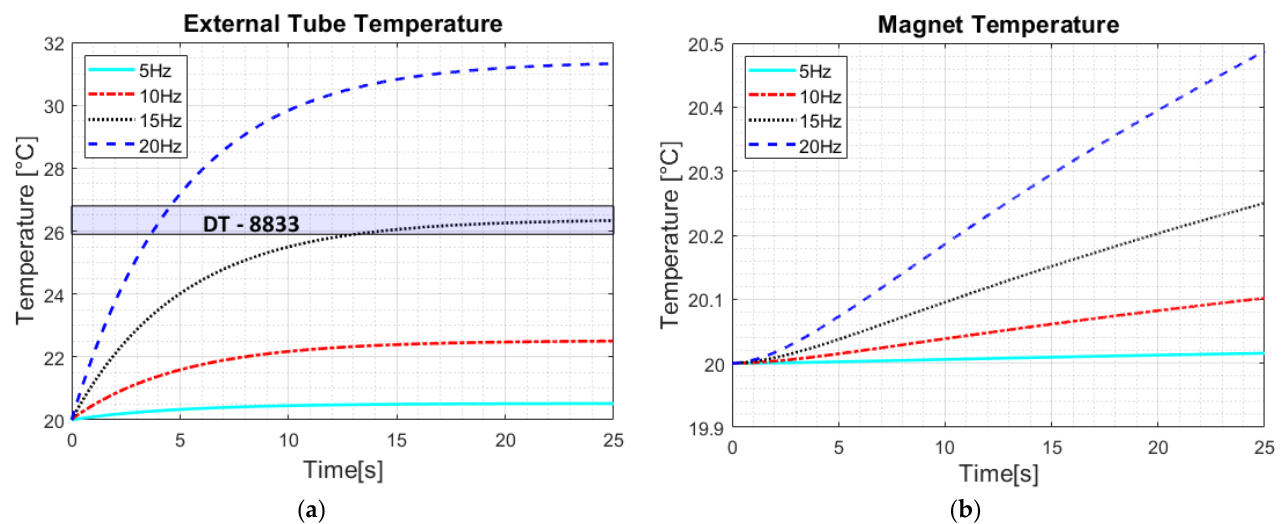
Figure 13. Temperature history ( a ) over the external steel tube surface at the mid-stroke position; ( b ) across the PMs for various frequencies.